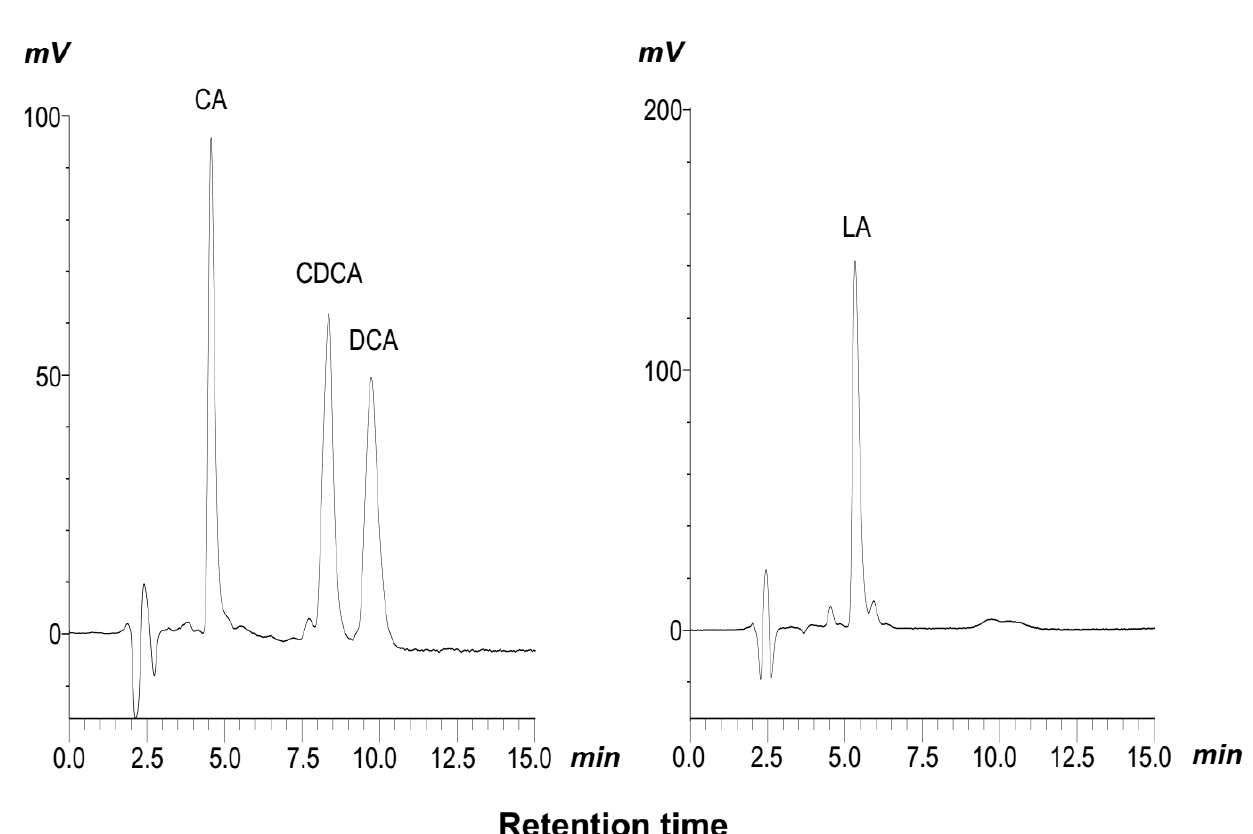
FIGURE 3 - HPLC separation of the authentic BAs. Twenty microliters of each standard (2500 µg/mL) were injected into the column. LiChrospherÆ 100 RP-18 5 µm column (100 x 4 mm), 20 mm of pre-column, 30 ºC of column temperature, 0.5 mL/ min of flow rate, UV at 202 nm, 20 µL of injection. The concentration of each BA was 2500 µg/mL.